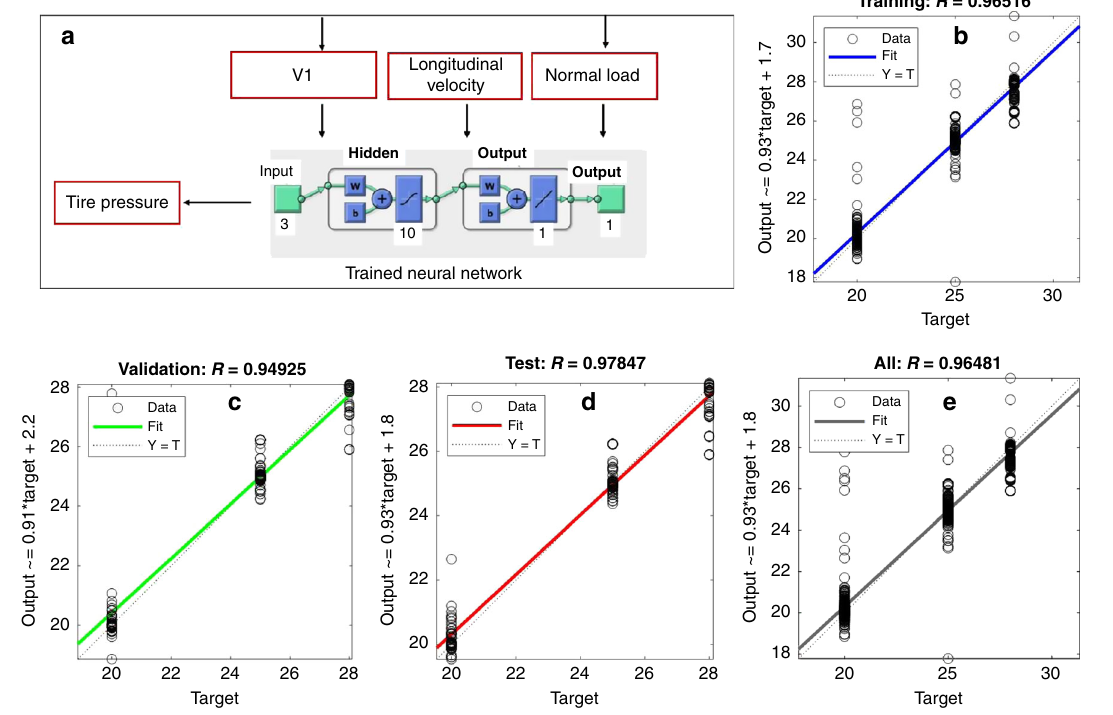
Fig. 6 Machine learning algorithm and fi tting performance. a The schematic of tire pressure monitoring algorithm. b – e The fi tting performance for training, testing, and